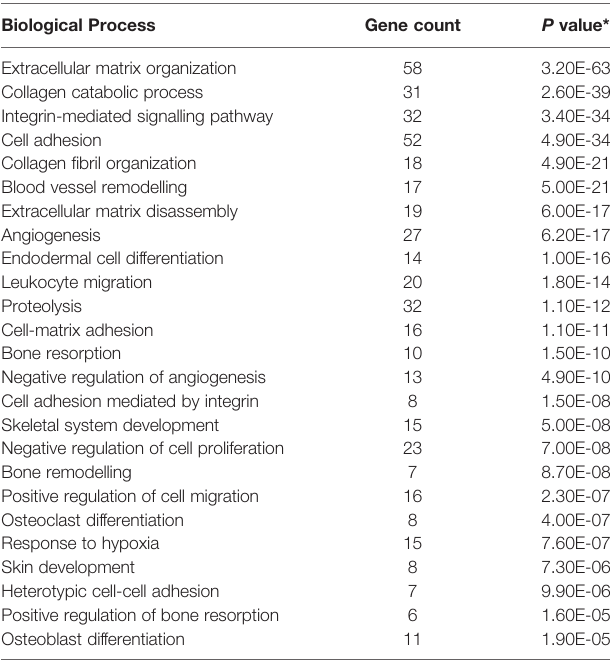
TABLE 2 | Top 25 enriched biological processes, determined by GO, in scWAT in individuals living with obesity. Biological Process Gene count P value*